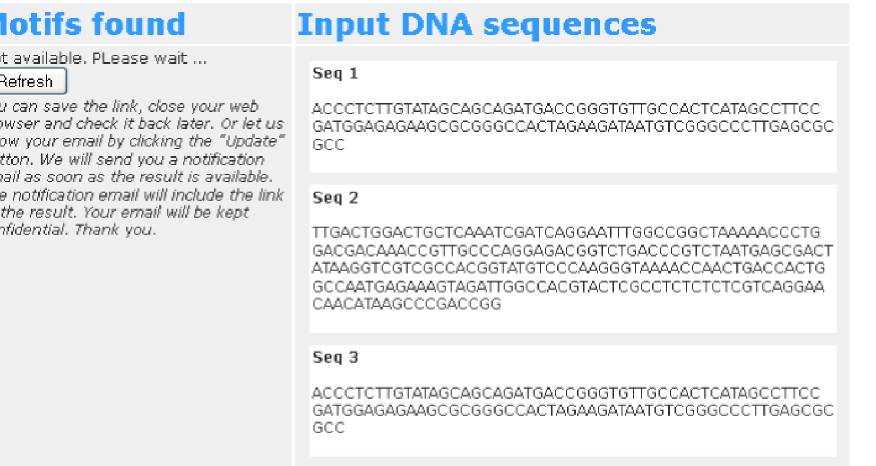
Figure 3. Result not available. An example of the results page when the submission has not been processed yet. Users can click on the ‘‘Refresh’’ button to update the processing